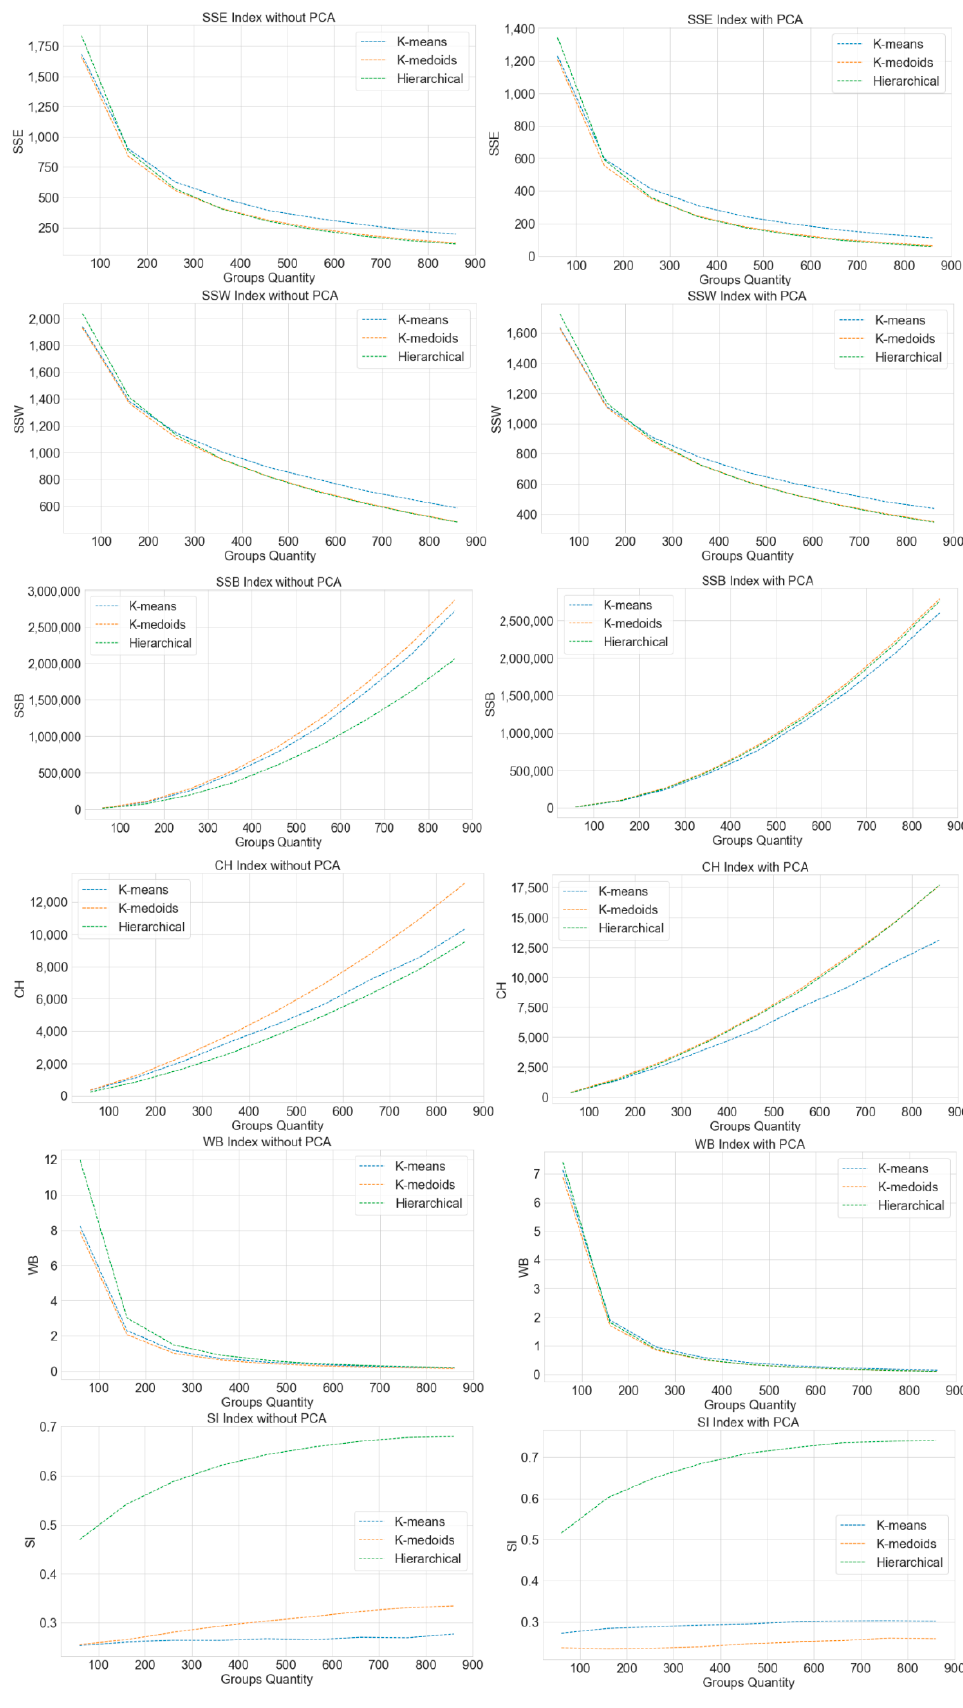
Figure 12. Shape comparison before and after the application of PCA to each Index.